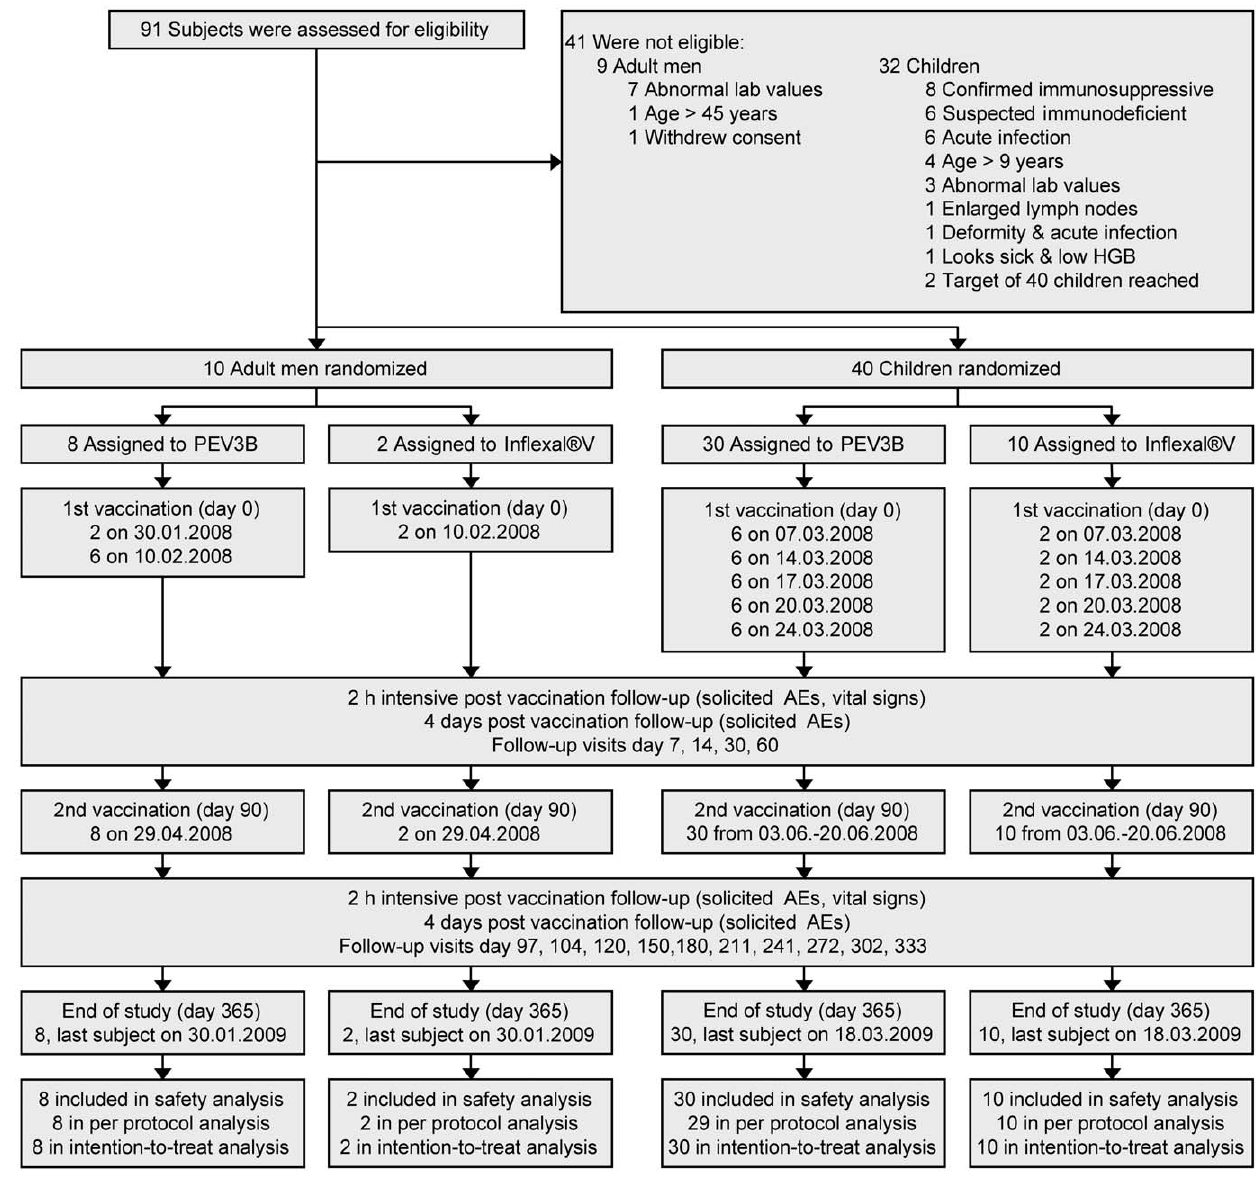
Figure 1. Study flow chart.